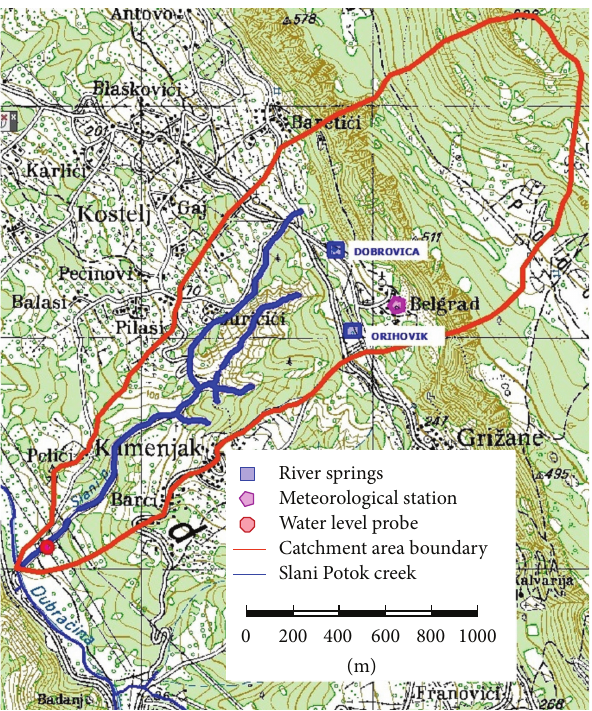
Figure 8: Location of the monitoring points in the Slani Potok catchment.